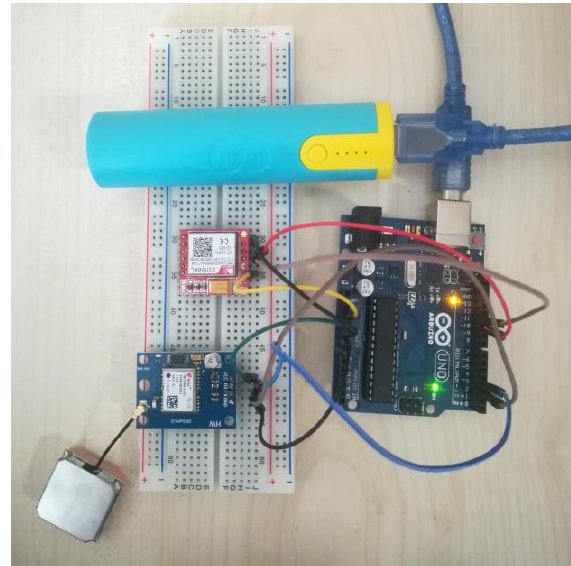
Figure 4. The practical system of the portable